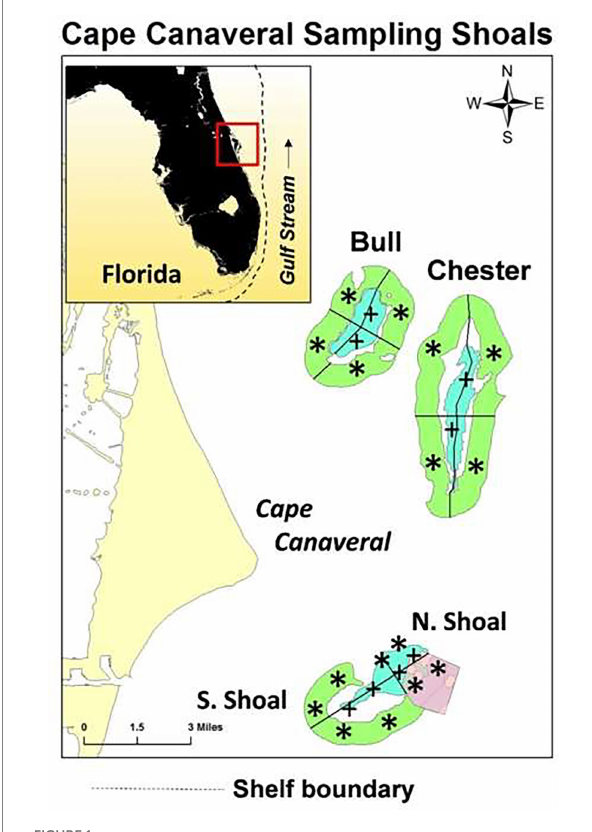
FIGURE 1 East coast of Florida showing the location of the Cape Canaveral Shelf (CCS) sampling region. Four sub-regions include Bull Shoal, Chester Shoal, North Shoal, and South Shoal. Ridge areas are shown in blue and swale areas in green. Sampling locations in each region are marked as “+” for ridge sites and “*” for swale sites. The pink area in North Shoal was the site of dredging activity for beach re- nourishment in the early winter of 2013.The inset shows the location of the study region and the dotted line shows the boundary of the shelf. SJR is outlet of the St. Johns River, SAI is the St. Augustine Inlet, MI is the Matanzas Inlet, and PI is the Ponce de Leon